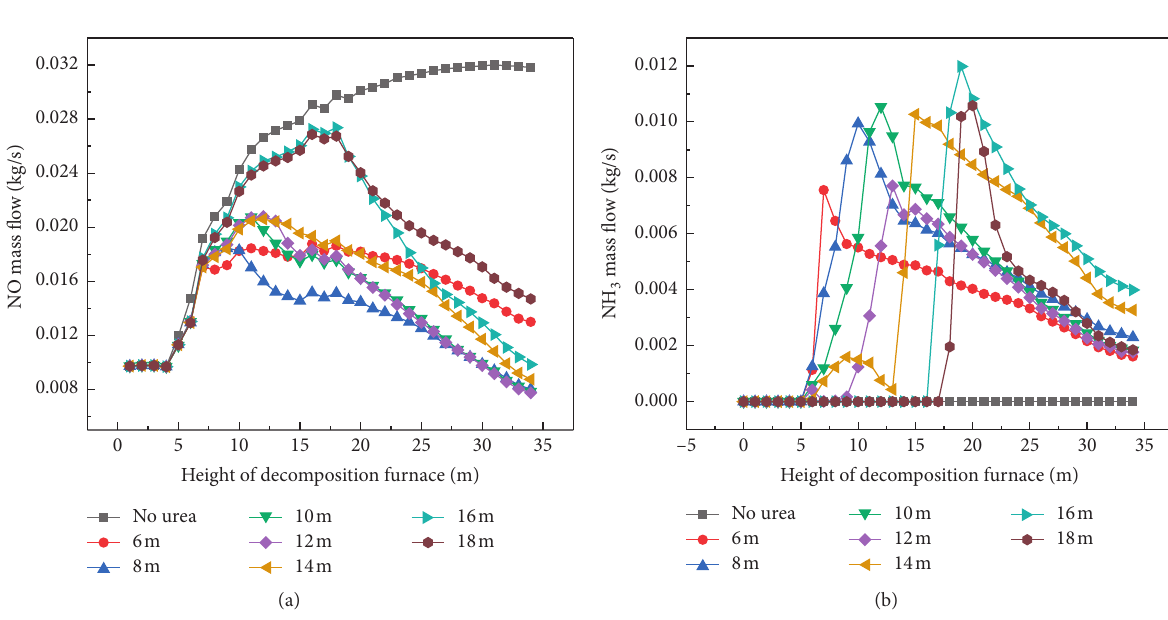
Figure 5: Flow curves of NO and NH 3 in the decomposing furnace under different injection positions. (a) NO and (b) NH 3